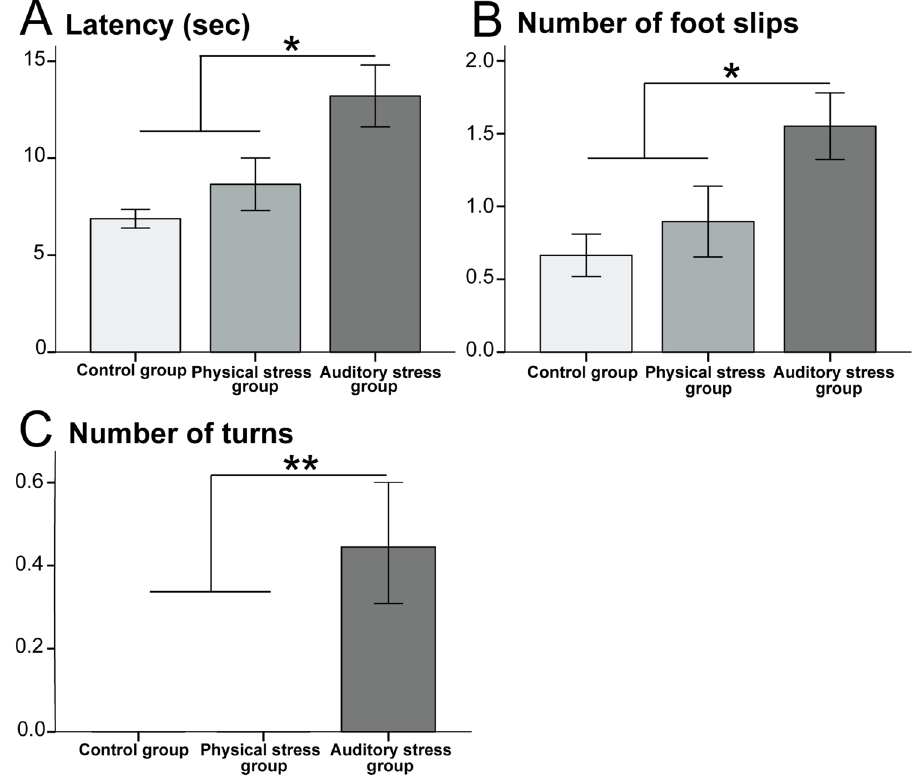
Figure 3. The balance beam test (BBT): The auditory stress group revealed ( A ) longer latency to travel across the beam (sec), ( B ) higher number of foot slips, and ( C ) higher number of turns compared with the two other groups. N = 10 in all groups. Results are reported as mean ± S.E.M. Asterisks indicate * p < 0.05 or ** p < 0.01.